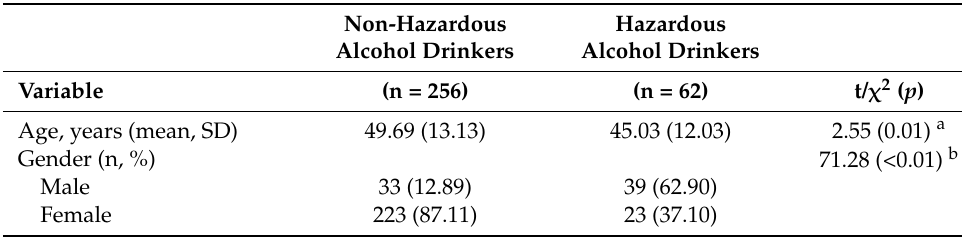
Table 1. Demographics of family members without and with hazardous alcohol-drinking behaviors (N =